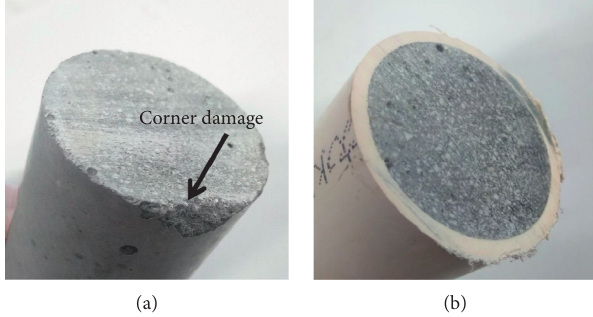
Figure 1: (a) Mortar surrounded by nothing. (b) Mortar surrounded by the PVC